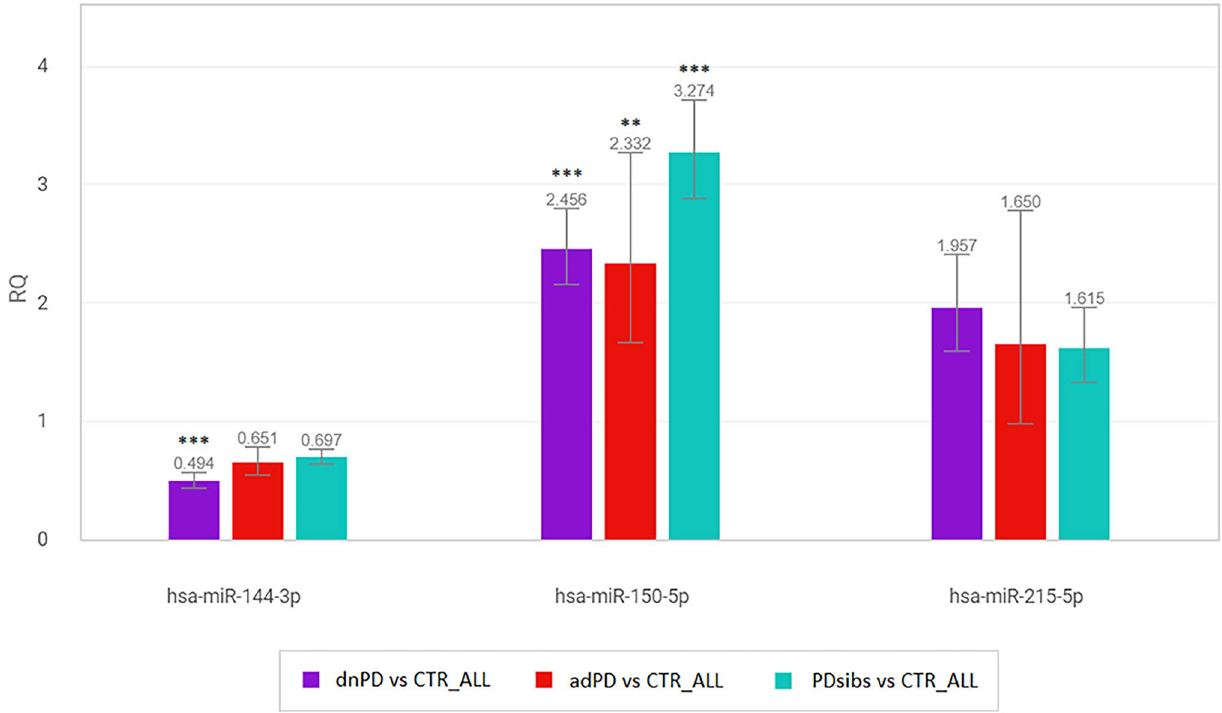
Figure 3. RQ (Relative Quantitation) plot. The plot displays the results of the RT-qPCR relative quantification (dnPDs, adPDs and PDsibs with respect to CTR_ALL) of the gene expression profile of hsa-miR-150-5p, hsa- miR-215-5p and hsa-miR-144-3p, in the validation. Standard asterisks notations indicates **for P-value < 0.01, and Fold Change (RQ) > 2 or < 0.5, and ***for P-value < 0.001 and Fold Change (RQ) > 2 or < 0.5. The image was obtained and downloaded from the software ThermoFisher Applied Biosystems™ Analysis Software web application (apps.thermofisher.com), Relative Quantitation Analysis Module (2020.2.1-Q2-20-build4 of 2020- 04-27). The image was afterwards edited with LibreOffice Draw, Libre Office version 5 (https:// www. libre office. org/).